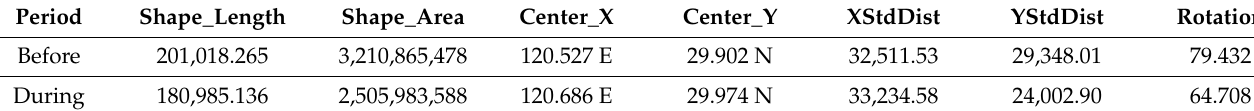
Table 3. Comparison of standard deviation ellipse characteristics of public sentiment distribution in Shaoxing city before and during the outbreak period.